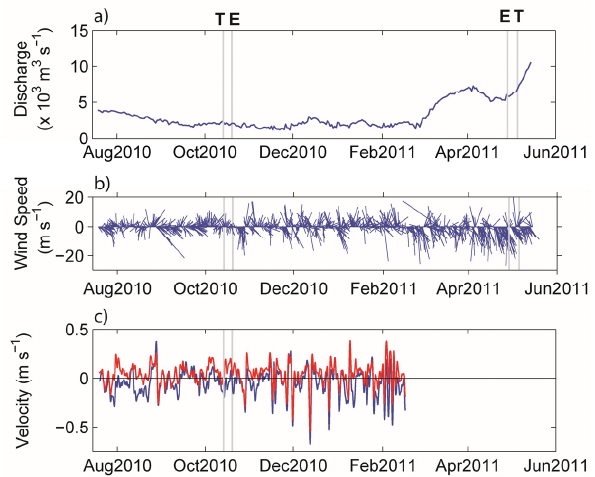
Figure 2. ( a ) Lower Atchafalaya River discharge at Morgan City, Louisiana; ( b ) Wind speed and direction at Dulac, Louisiana. Length of vector indicates speed of wind; angle of vector denotes direction from which the wind is blowing; ( c ) Near ‐ surface (blue) and near bottom (red) current velocity in the Houma Navigation Canal at Cocodrie, LA. Positive values denote landward flow; negative values denote seaward flow. The gray vertical lines indicate tidal cycle sampling events during tropic ( T ) and equatorial ( E ) phases of the fortnightly cycle.